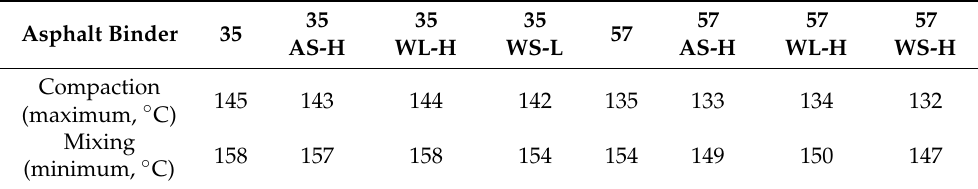
Table 5. Processing temperatures of asphalt mixtures estimated based on the dynamic viscosity measurements.